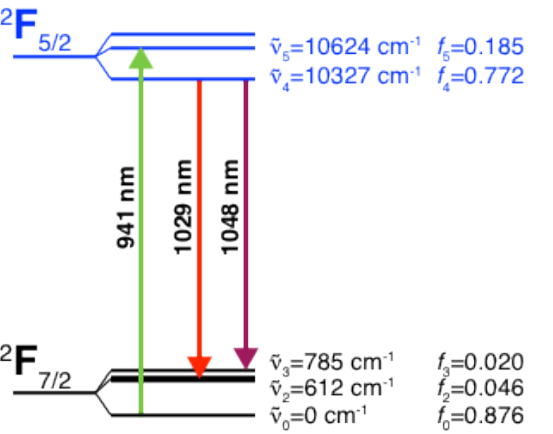
Figure 4. Energy level scheme and laser transitions in